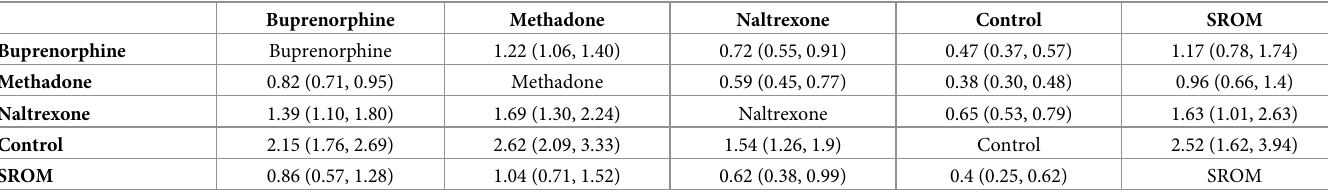
Table 3. Risk ratio estimates for treatment retention and 95% credible interval (CrI) 1